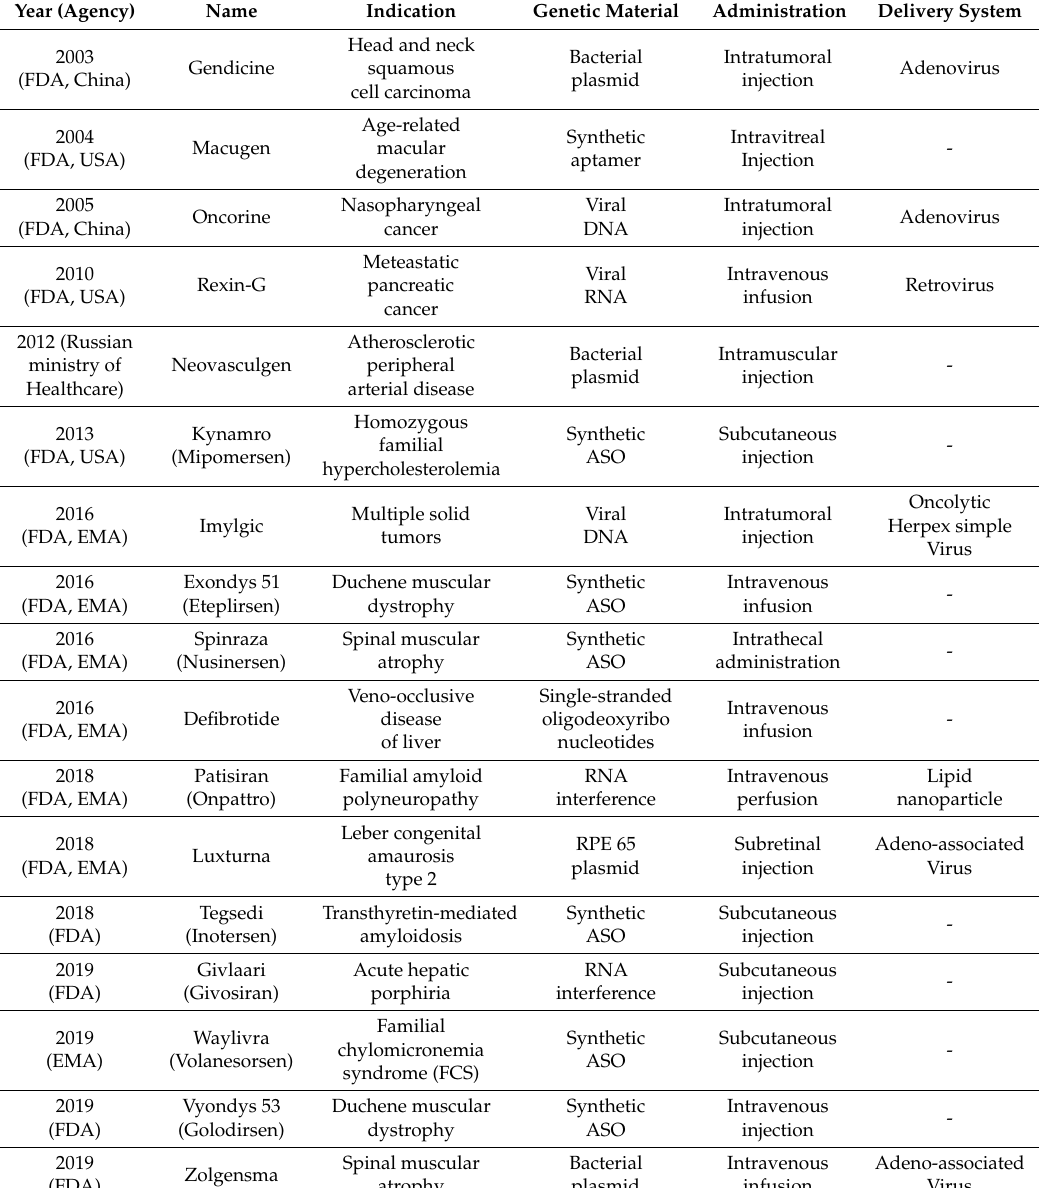
Table 1. Gene therapy-based drugs on market for in vivo human use, including synthetic